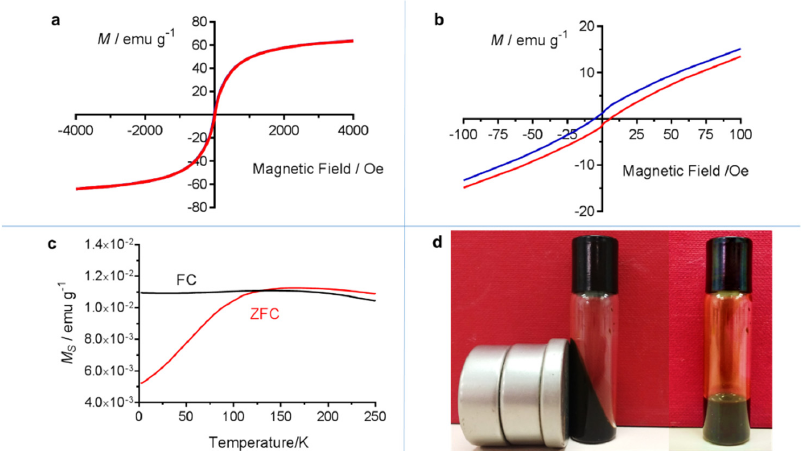
Figure 2. ( a ) Magnetization plot at 300 K of the as-prepared fluid; ( b ) Enlargement of the hysteresis loop of Figure 2a in the low field region; ( c ) Temperature-dependent ZFC-FC magnetization curves of the as-prepared ferrofluid measured at 50 Oe; ( d ) Effect of an external magnet on the ferrofluid.